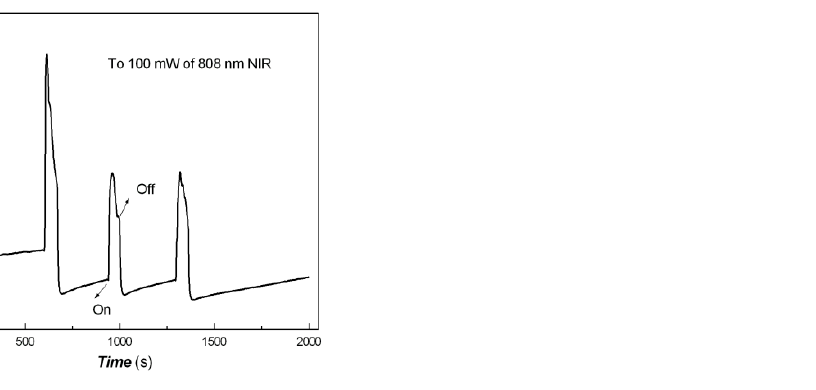
Figure 12. Photo-responses of Au/PANi nanocomposites functionalized with beta-cyclodextrin to 100 mW 808 nm NIR (Sample 2–chloroauric acid (50 mL)).